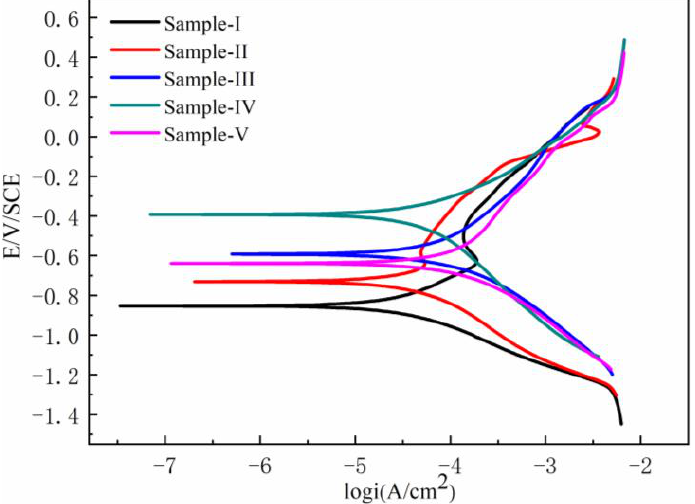
Figure 10. FESEM morphology of the worn surface of two coatings: ( a ) sample-I and ( b ) sample-IV.